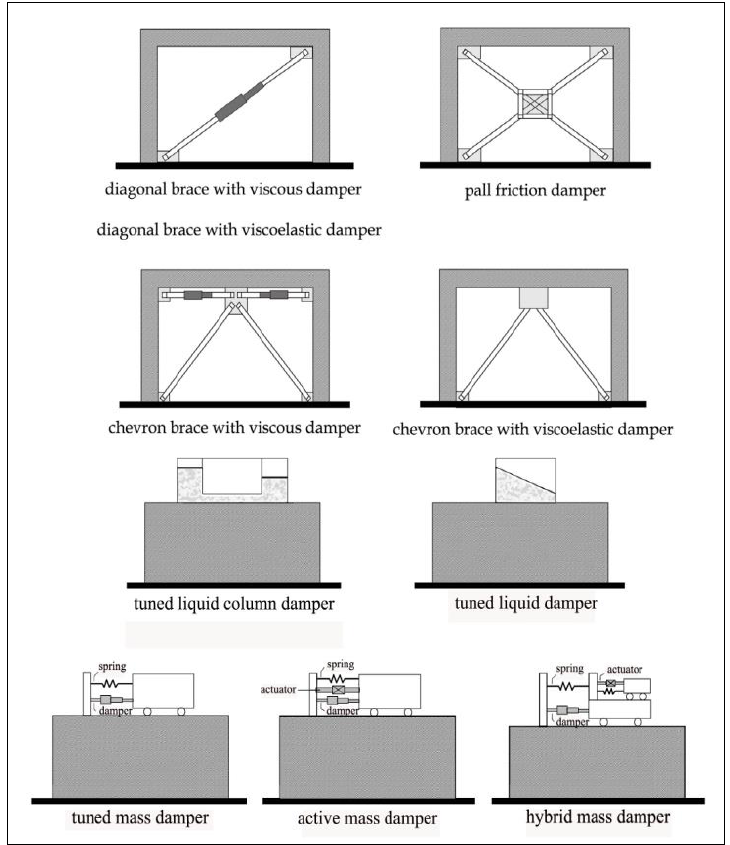
Figure 5. Vibration damping systems (figure by